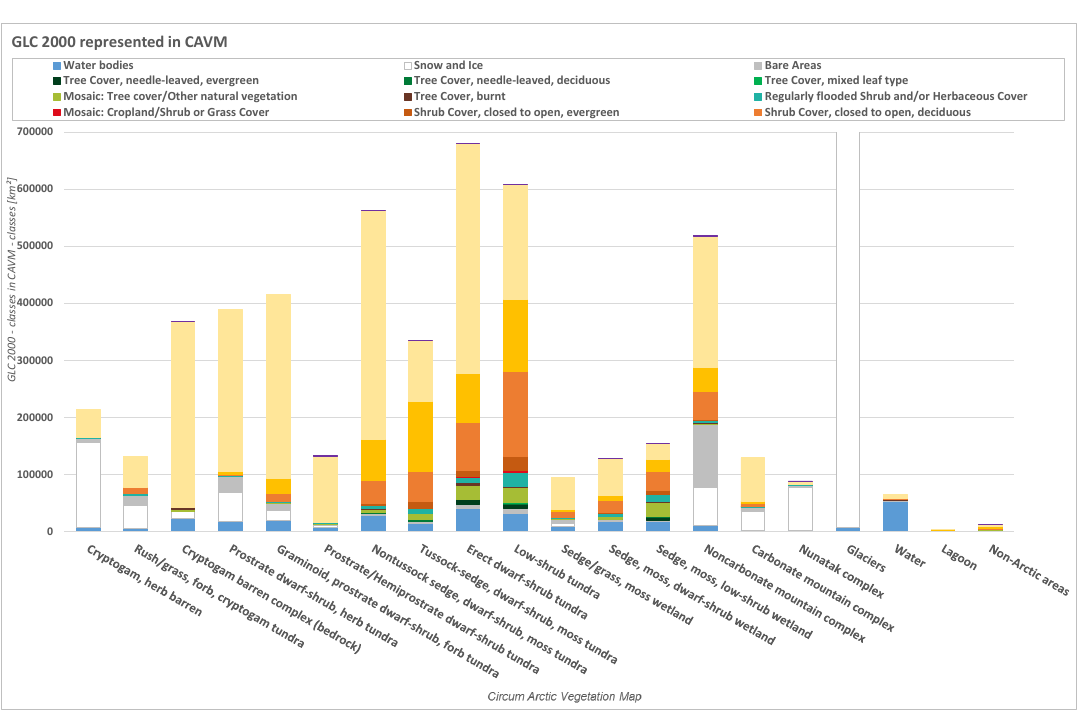
Figure 3. Comparison of GLC2000 classes with CAVM